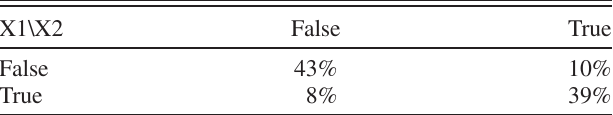
TABLE II. Average contingency table of the test-retest for the 30 items of the FCI (data from Lasry et al.